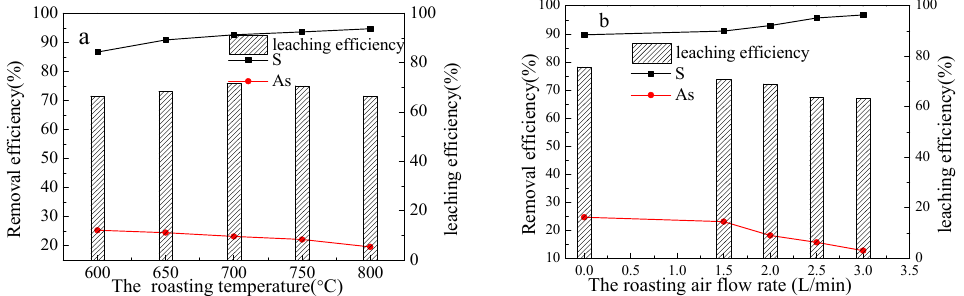
Figure 5. Effects of the temperature ( a ) and air flow rate ( b ) on the removal efficiency of As and S, and leaching efficiency of gold in single stage roasting.